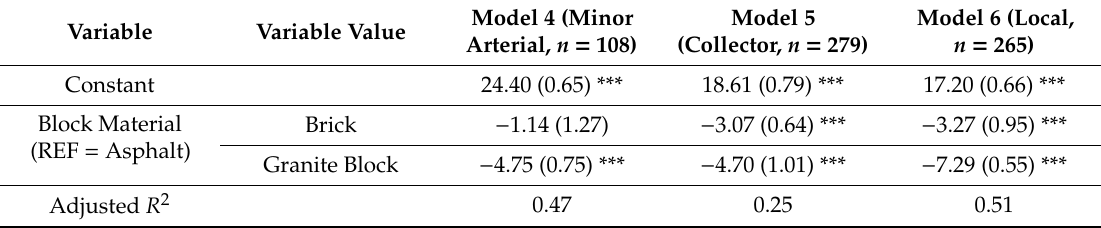
Table 4. Results of stratified fixed e ff ects regression of vehicle speed by street class